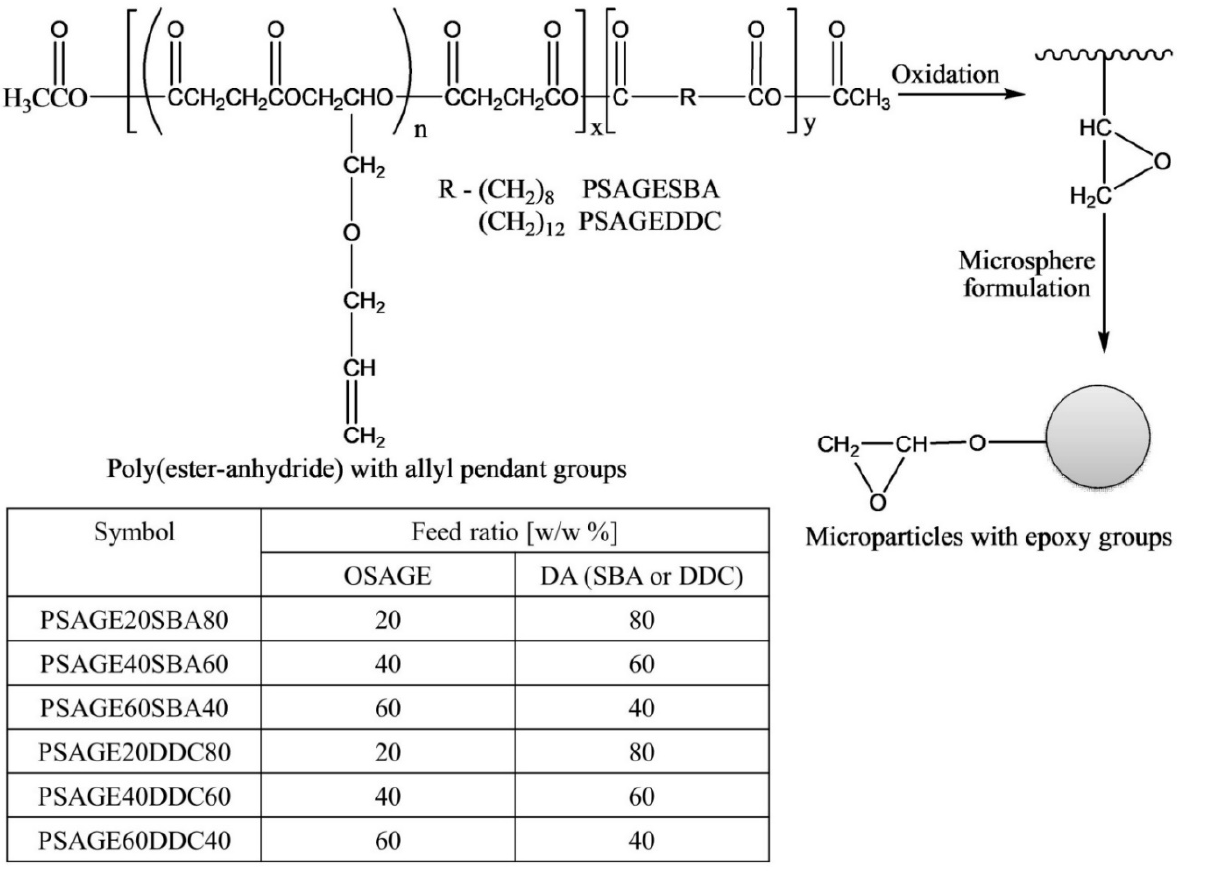
Figure 16. Preparation of microspheres with surface epoxy groups as described by Jaszcz et al. Adapted with permission from [50]; published by Elsevier, 2012.